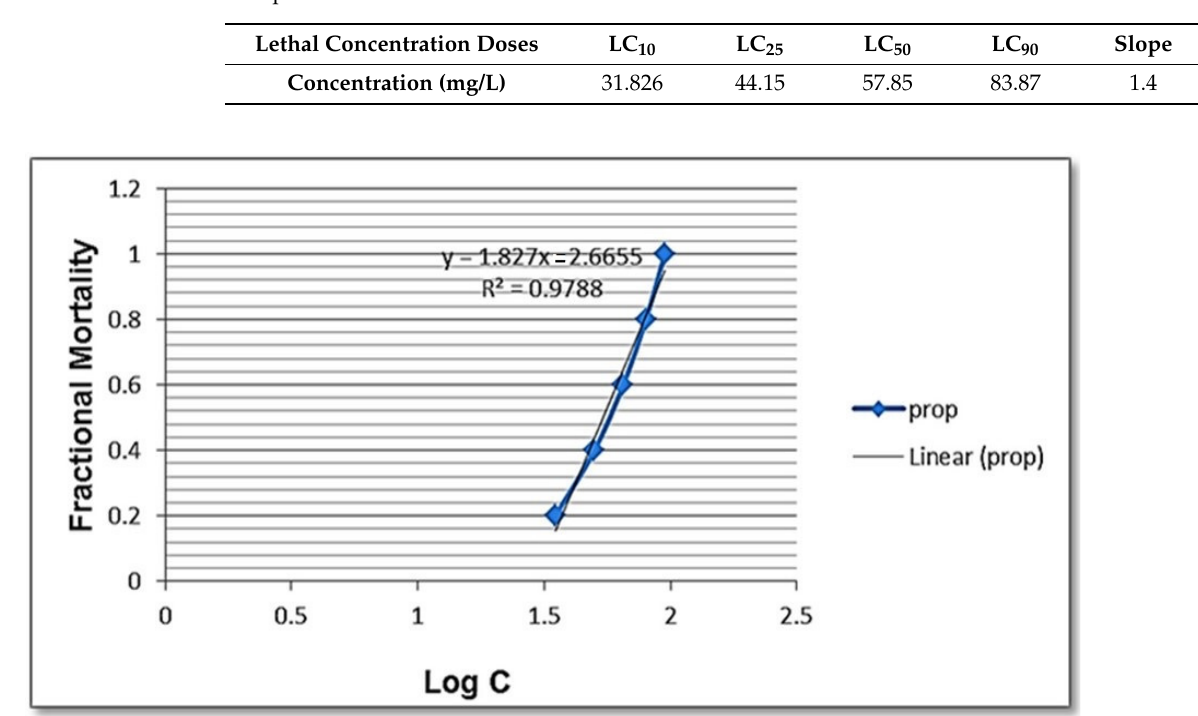
Figure 6. Molluscicidal effect of SeNPs against B. alexandrina snails as shown in probit analysis.